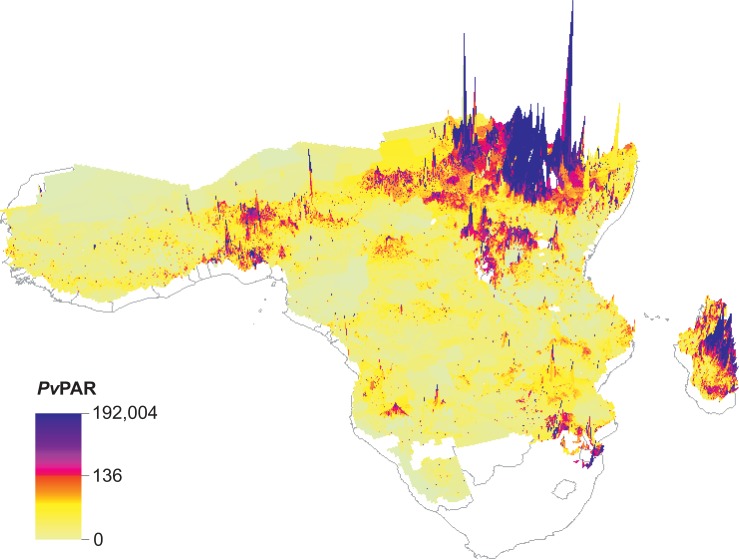
Spatial map of the distribution of the PvPAR.The map resolution is 5 x 5 km, and the 3-dimensional scale was square-root transformed to allow plotting.